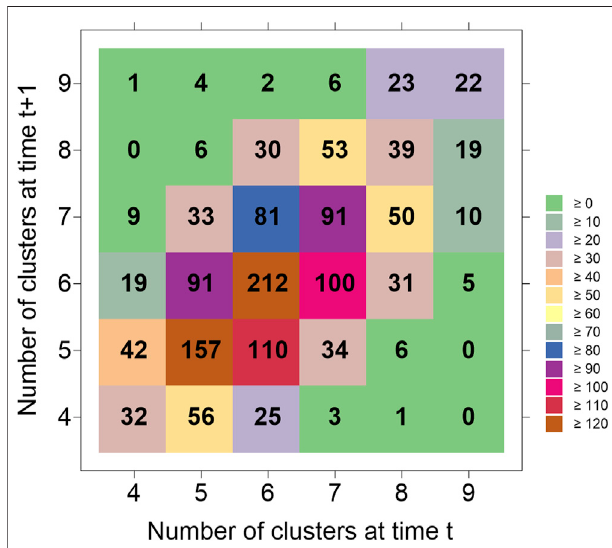
FIGURE 8 | Transformation of clustering numbers in different years. t represents the cluster number in the current year, and t+1 represents the cluster number in the next year.